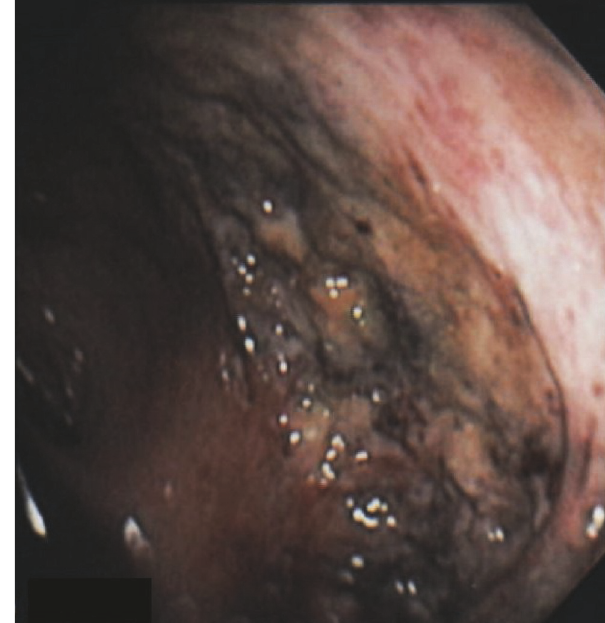
Figure 2: Flexible sigmoidoscopy showing a part of circumferential ulcer in the